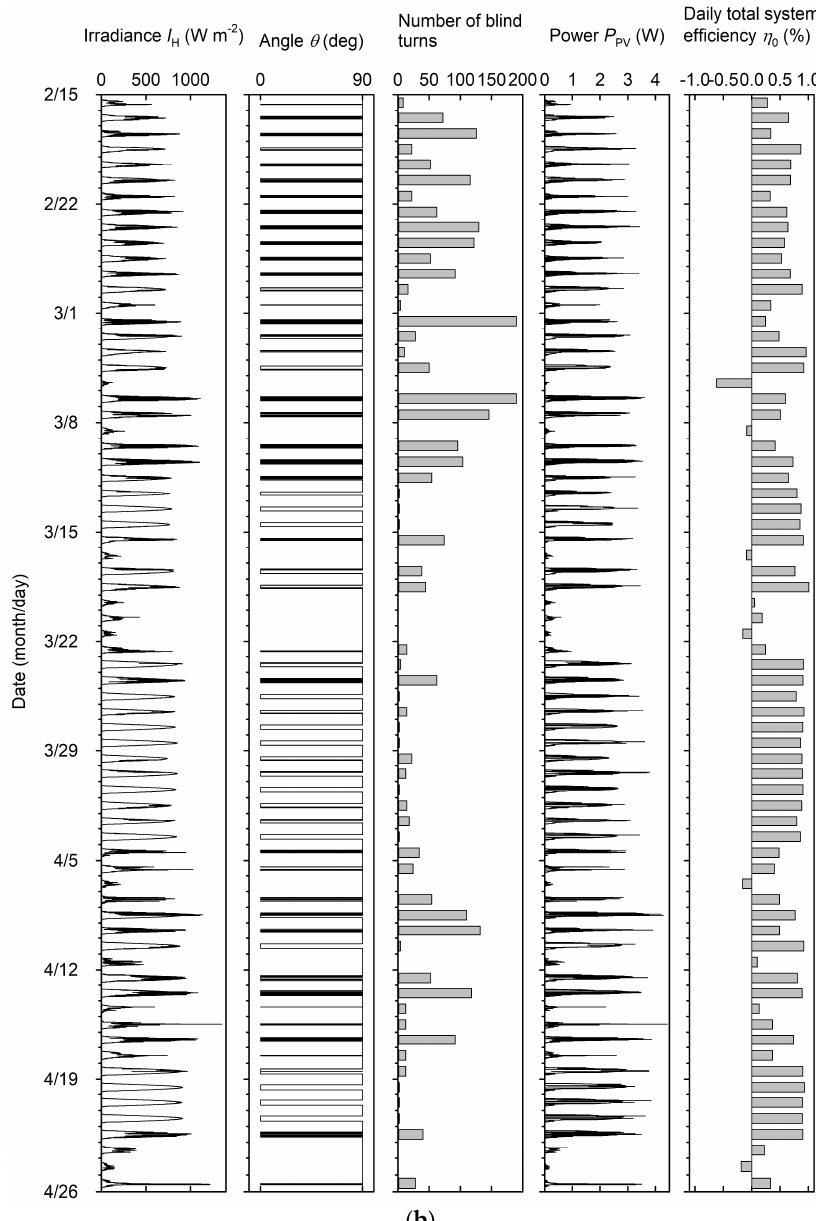
Figure 10. Verification of automatic operations of the PV blind system in winter ( a ) and in spring ( b ). On 14 February, blind system operations were suspended to install the additional light-emitting diode (LED) load to the system.